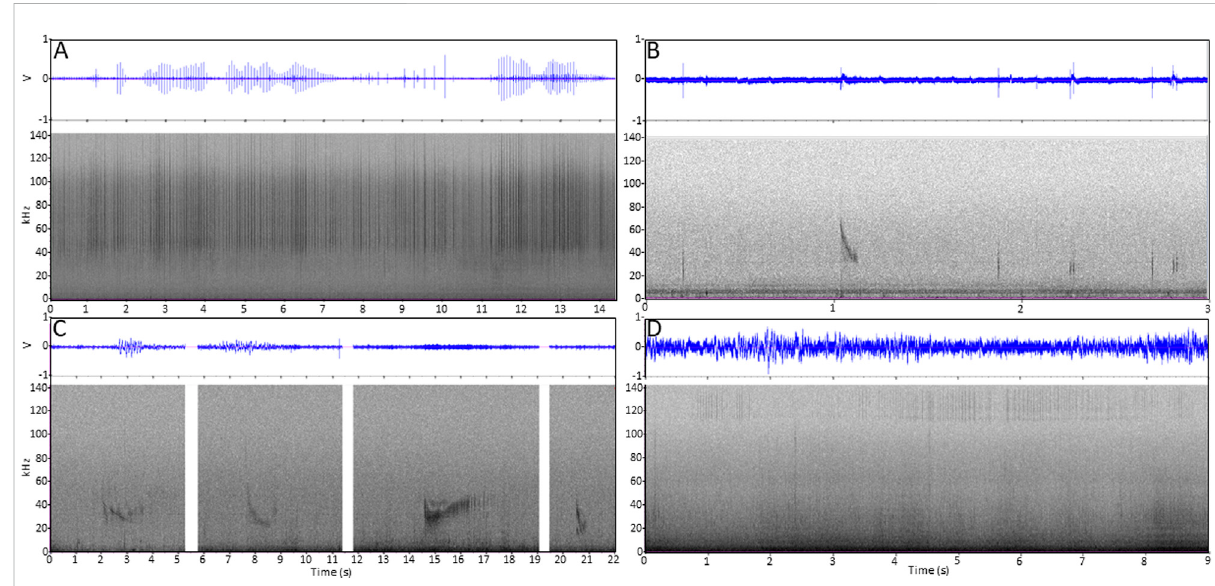
FIGURE 2 Waveform and spectrogram (linear 0 – 144 kHz, Hanning window, 1024 FFT, 75% overlap) of (A) 14 s of data with examples of beluga echolocation from Krusenstern Point on 20 November 2015 from at least three individuals (click trains show highest amplitude from approximately 40 kHz – 130 KHz); (B) 3 s of data with examples of transient killer whale single clicks, double clicks, and a high frequency whistle from Krusenstern Point on 10 July 2015 (clicks show highest amplitude from approximately 24 – 34 kHz); (C) Four sound recording segments from Krusenstern Point on different dates during July 2015 showing transient killer whale high frequency whistles (whistlesare modulated inthe range 17 – 51 kHz); (D) Nine seconds of data with harbor porpoise echolocation from Chamisso Island on 12 January 2015 (click trains show highest amplitude from approximately 115 kHz – 140 KHz).